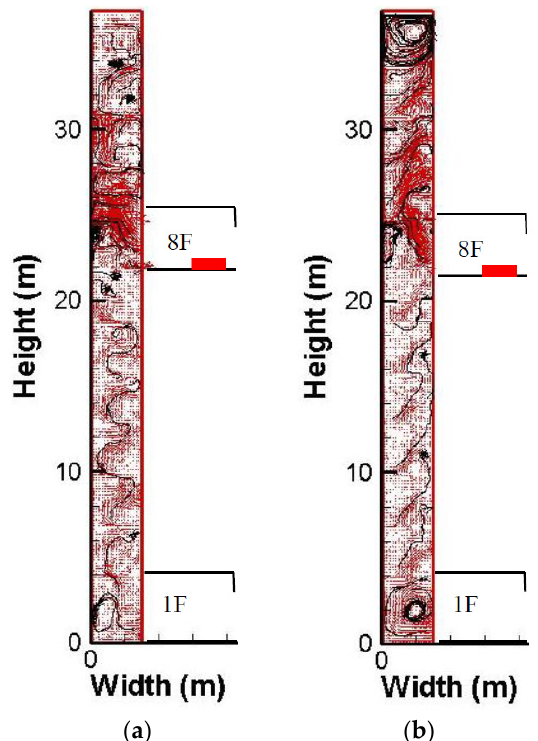
Figure 7. Velocity vector graphs at 3.5 m/s: ( a ) 52 s and ( b ) 390 s.